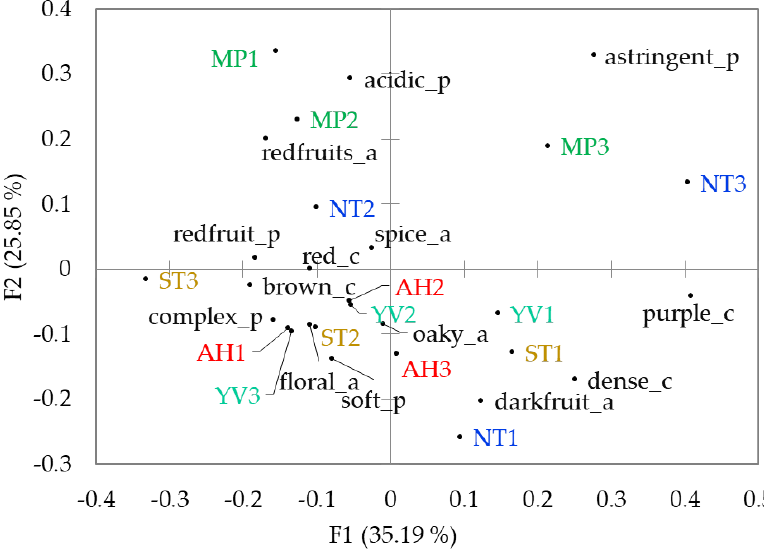
Figure 3. Correspondence analysis biplot of the 15 Pinot Noir wines using Pivot © Profile. AH, Adelaide Hills; MP, Mornington Peninsula; YV, Yarra Valley; ST, Southern Tasmania; NT, Northern